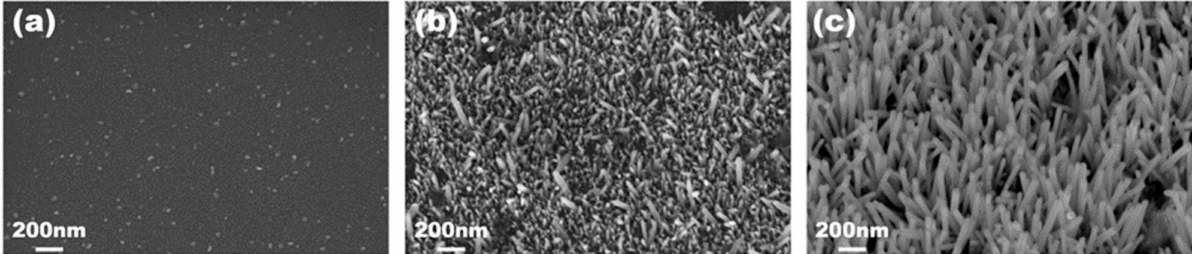
Figure 1. SEM images of Si samples coated with ( a ) 10-nm-thick ZnO film, and with additional wet growth of ZnO nanostructures by hydrothermal synthesis for 1 h ( b ) and 3.5 h ( c